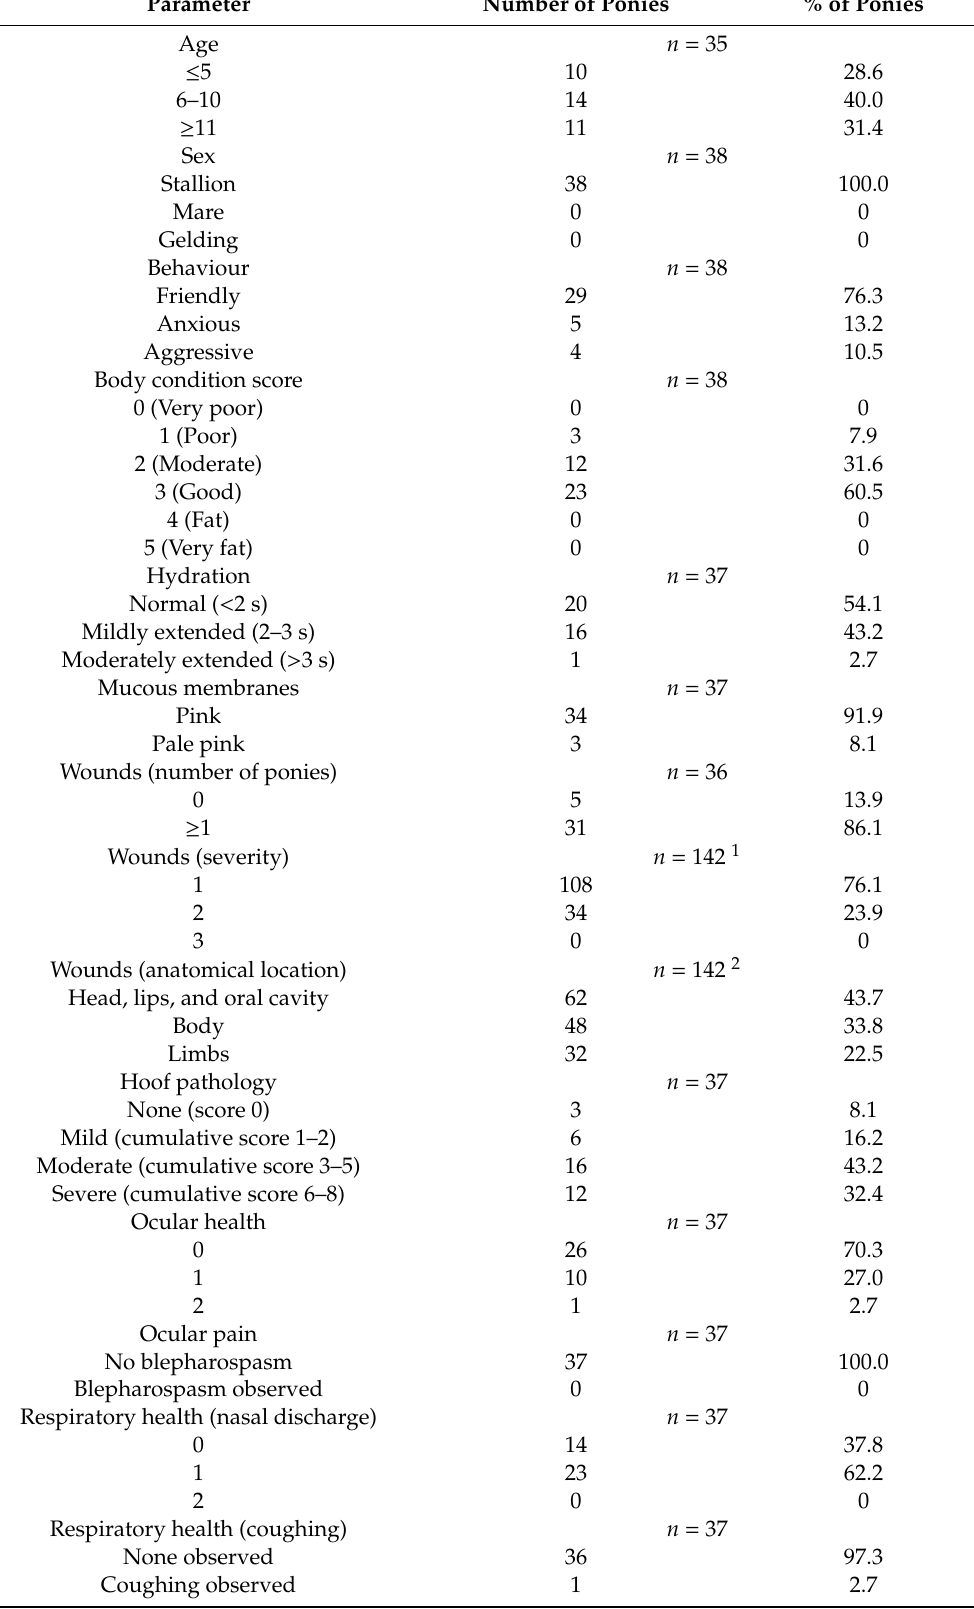
Table 3. Health examination results in Gili